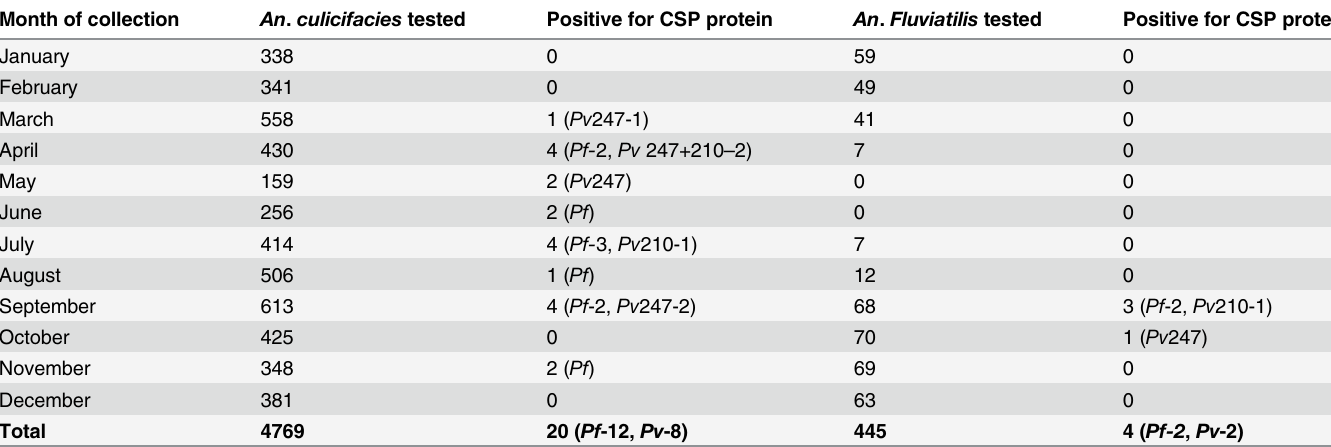
Table 5. Month wise results of sporozoite ELISA